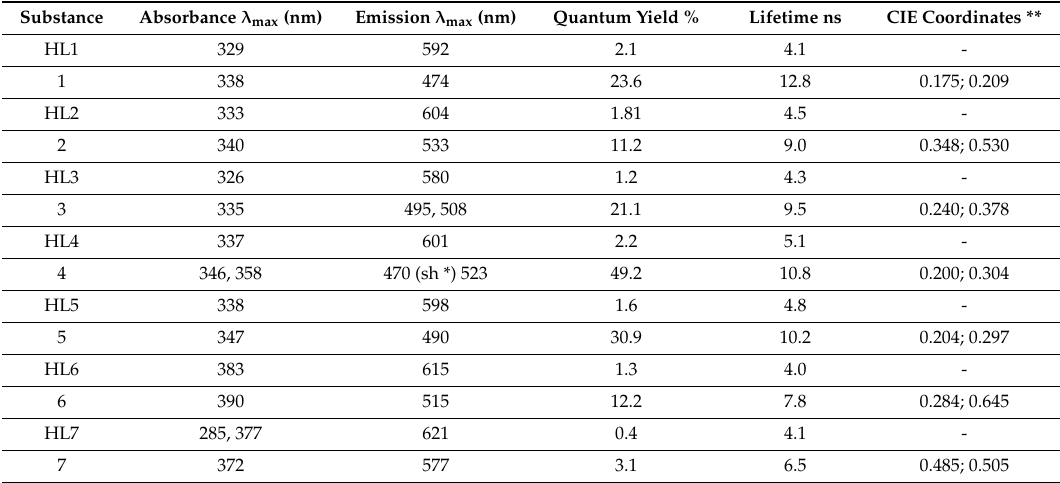
Table 1. UV–vis, photoluminescence spectra data for title ligands and